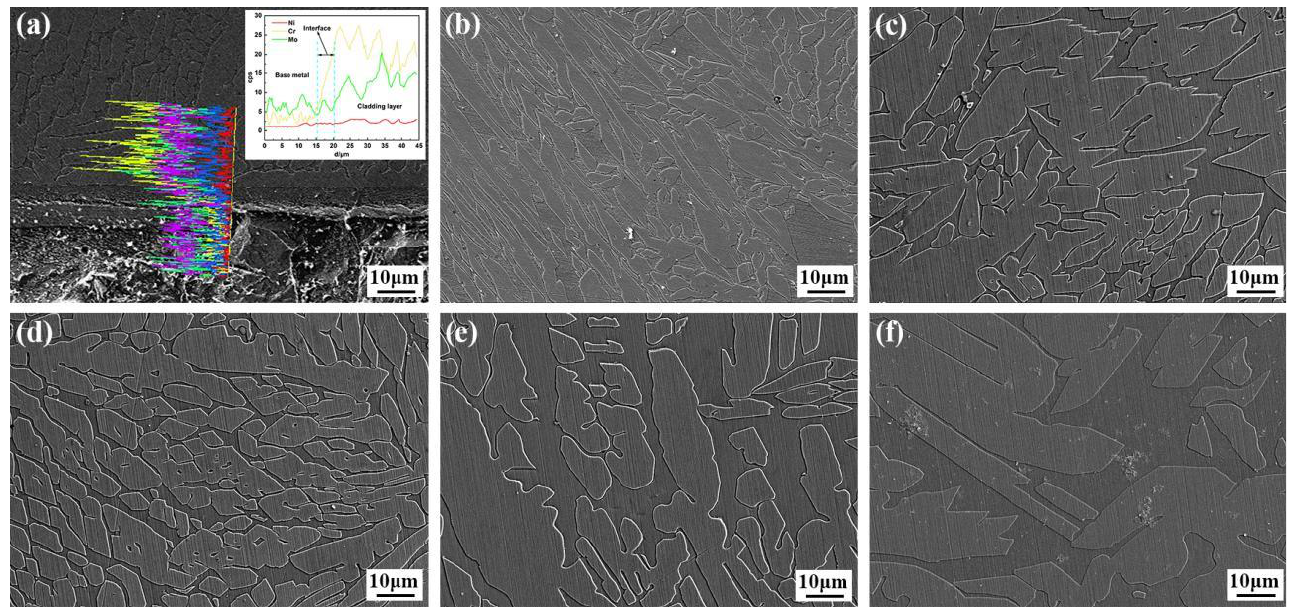
Figure 4. The SEM results of specimens under different current. ( a ) the Line Scanning result (80 A); ( b ) 80 A; ( c ) 90 A; ( d ) 100 A; ( e ) 110 A; ( f ) 120 A. In order to analyze the microstructural composition in details, the cross-sectional microstructure of the specimen and the top microstructure of the cladding layer on the condition of different current and austenite/ferrite mass ratio in mirostructure are shown in Figure 5. The austenite phase was shown as white while the gray region was the ferrite